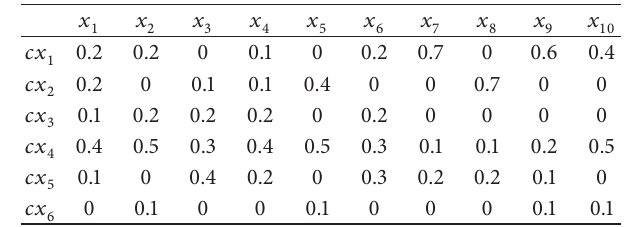
Table 5: Values of 𝛼 𝑖𝑗 between human errors and items in